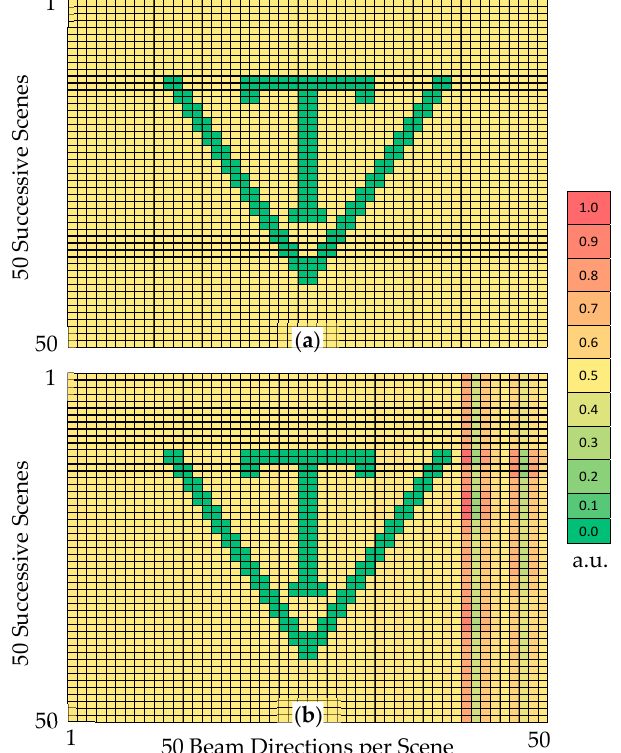
Figure 12. Two sets of 50 horizontal strips, each representing the relative beam power distribution incident to the instrument aperture from 50 directions. ( a ) Target scenes used to create the ANN input, and ( b ) the corresponding ANN output.